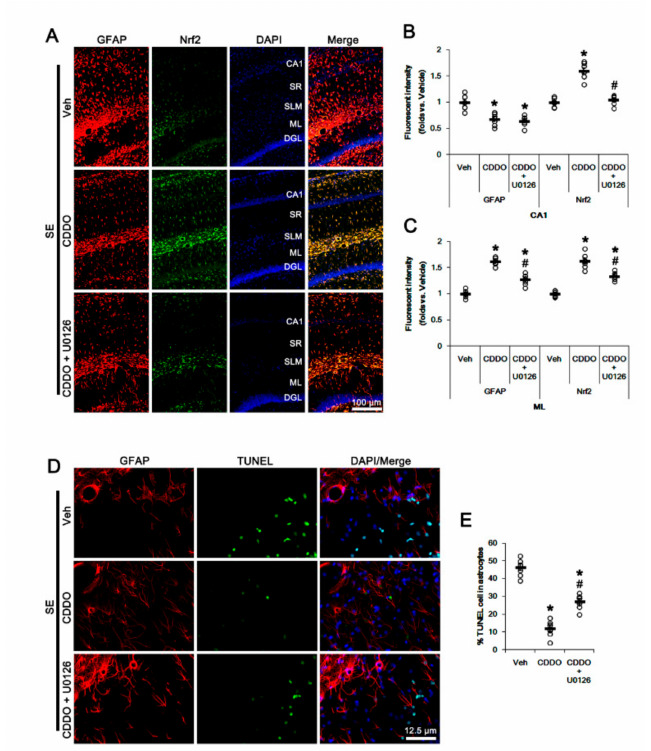
Figure 7. E ff ects of CDDO-Me and U0126 co-treatment on Nrf2 expression and astroglial responses following SE. U0126 co-treatment does not a ff ect the abolishment of reactive CA1 astrogliosis by CDDO-Me. However, U0126 co-treatment inhibits the upregulation of Nrf2 expression induced by CDDO-Me in CA1 astrocytes and ML astrocytes. In addition, U0126 abrogates the protective e ff ect of CDDO-Me against SE-induced ML astroglial apoptosis. ( A ) Representative photos of GFAP and Nrf2 in the hippocampus. Abbreviations: CA1, CA1 pyramidal cell layer; SR, stratum radiatum; SLM, stratum lacunosum-moleculare; ML, molecular layer of the dentate gyrus; DGL, dentate granule cell layer. ( B , C ) Quantification of the fluorescent intensities of GFAP and Nrf2 in CA1 ( B ) and molecular layer regions ( C ). Open circles indicate each individual value. Horizontal bars indicate mean value. Vertical bars indicate S.E.M. (*,# p < 0.05 vs. vehicle and CDDO-Me, respectively, one-way ANOVA followed by Newman-Keuls post hoc test; n = 7, respectively). ( D ) Representative photos of apoptosis of ML astrocytes. ( E ) Quantification of the fraction of TUNEL-signals in ML astrocytes. Open circles indicate each individual value. Horizontal bars indicate mean value. Vertical bars indicate S.E.M. (*,# p < 0.05 vs. vehicle and CDDO-Me, respectively, one-way ANOVA followed by